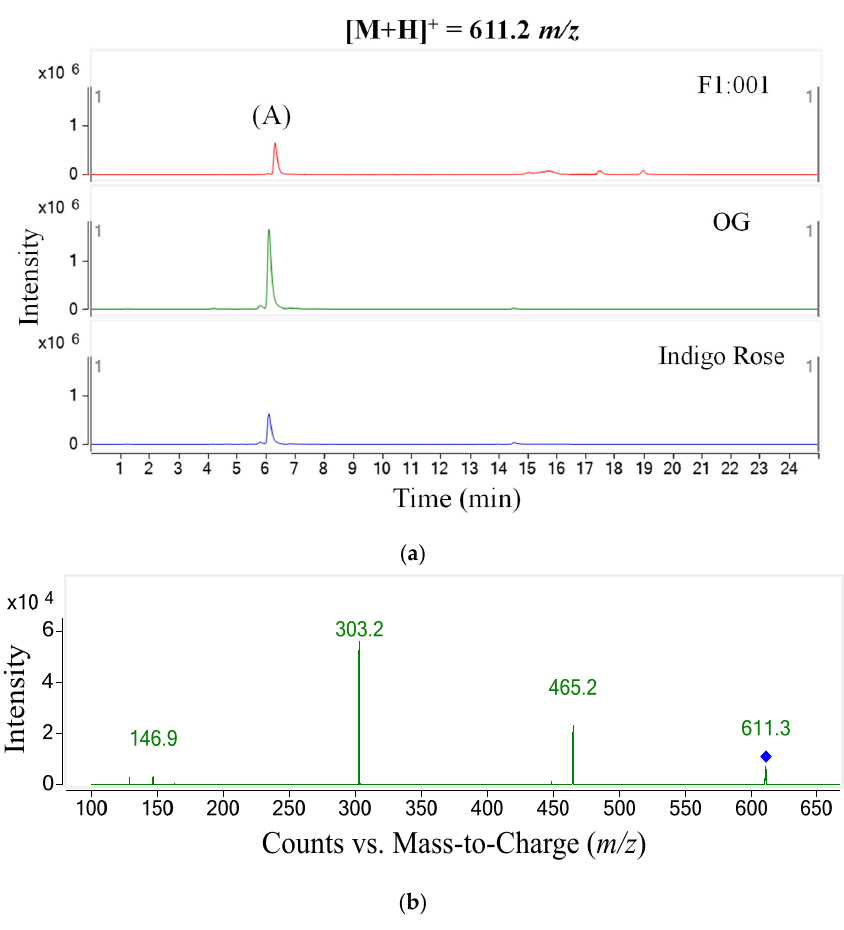
Figure 4. Chromatogram ( a ) and MS–MS fragments ( b ) of [M+H]+ ion with 611.2 m / z in three tomato varieties.